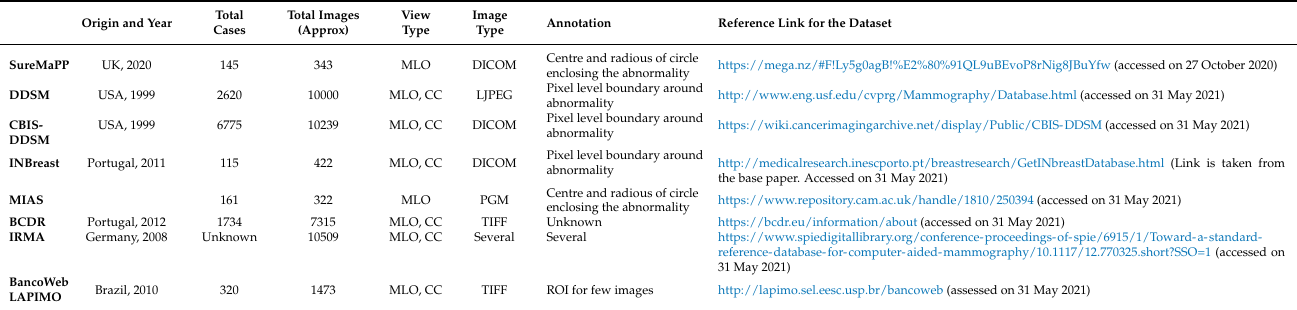
Table 1. List of commonly used mammogram datasets and reference